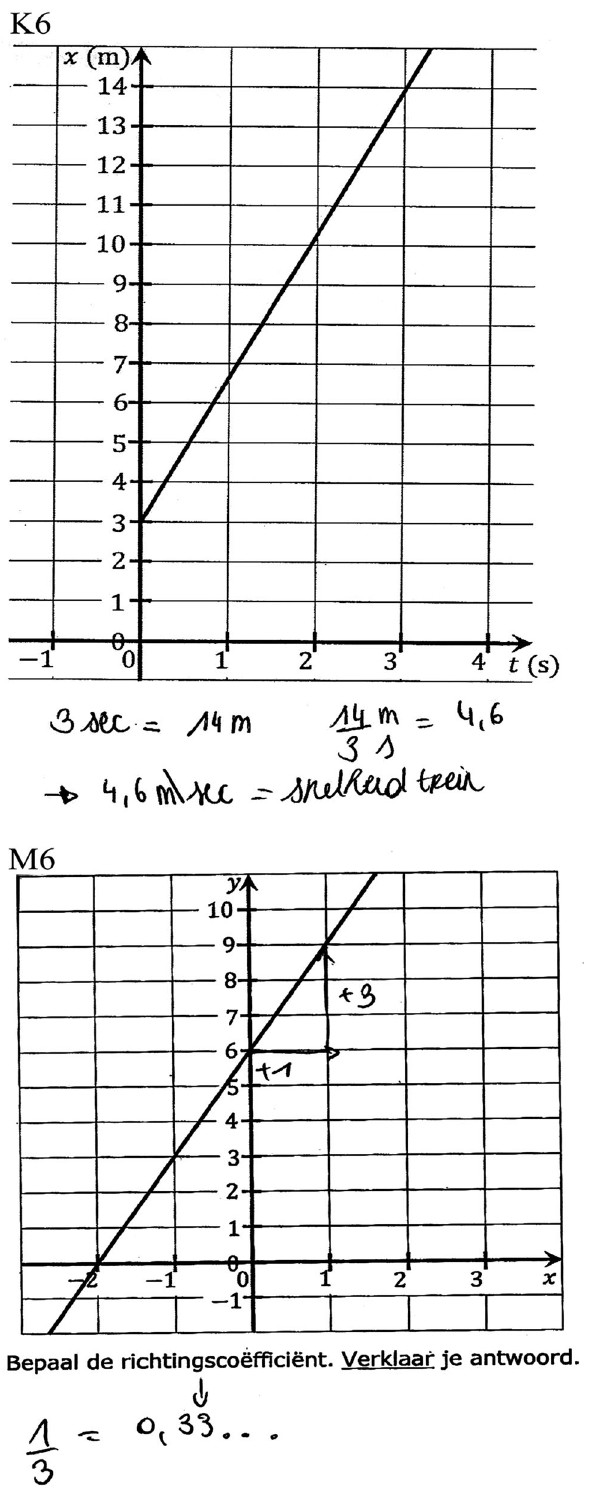
FIG. 14. Example of isomorphic questions K6 and M6 (with positive slopes) solved by the same student. In K6, the interval or point confusion occurs resulting in an incorrect answer, but in M6 a triangle is drawn (S7) with a horizontal step size of þ 1 resulting in a correct answer. The text in the K6 translates as “ speed or velocity train.